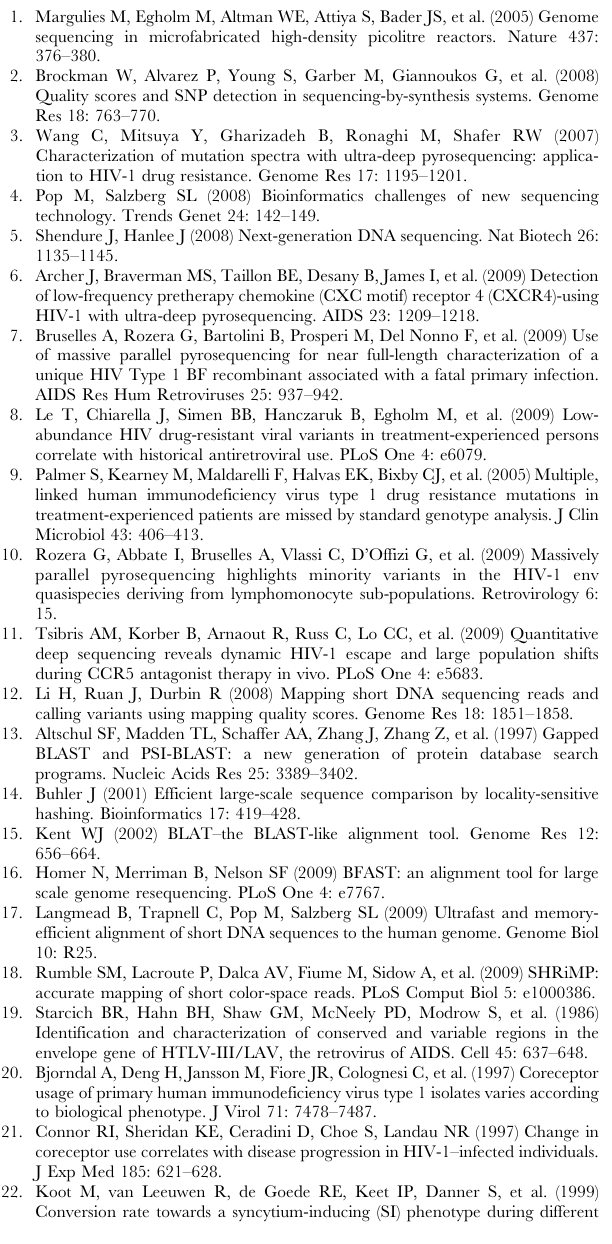
Correction of the V3 sequence based on HXB2, and